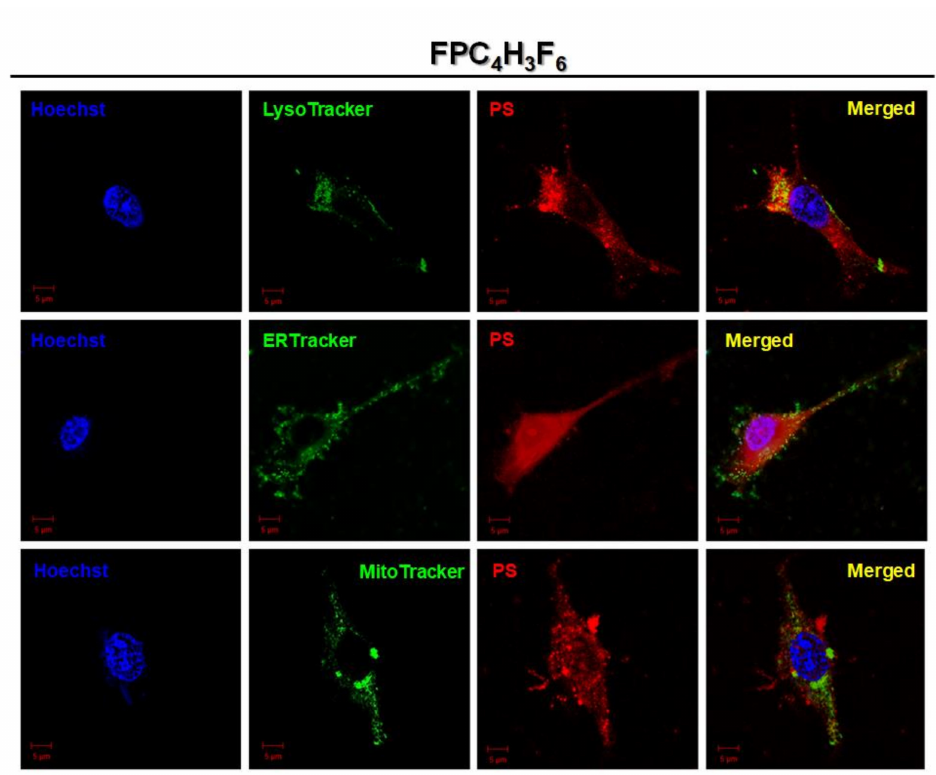
Figure 5. Laser scanning confocal fluorescence microscopy images of cells showing intracellular localization of F 2 POH and FPC 4 H 3 F 6 . Cells were marked with specific probes for endoplasmic reticulum (ERTracker), lysosomes (LysoTracker), and mitochondria